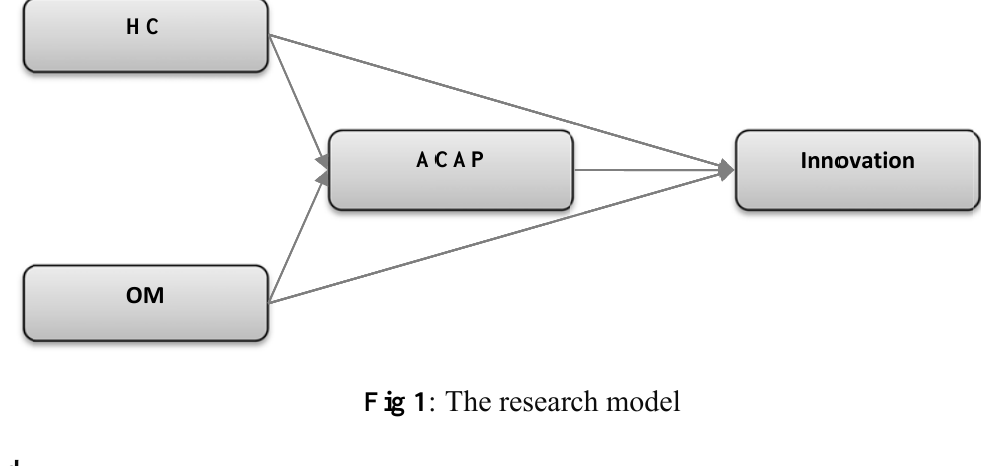
Measuremen Goodness of fi Chi-square Chi-square/deg GFI RMSR NFI NNFI CFI A AGFI